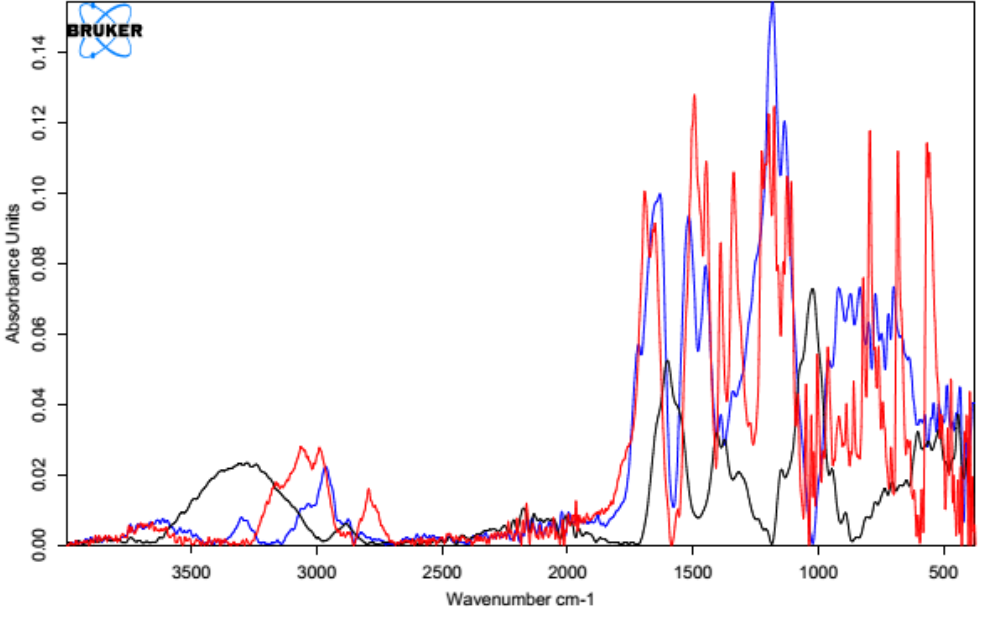
Figure 21. IR spectrum of native HA (black line) vs. HA–FFPLADDVTP conjugate (red line) and the spectrum of the used peptide (blue line).